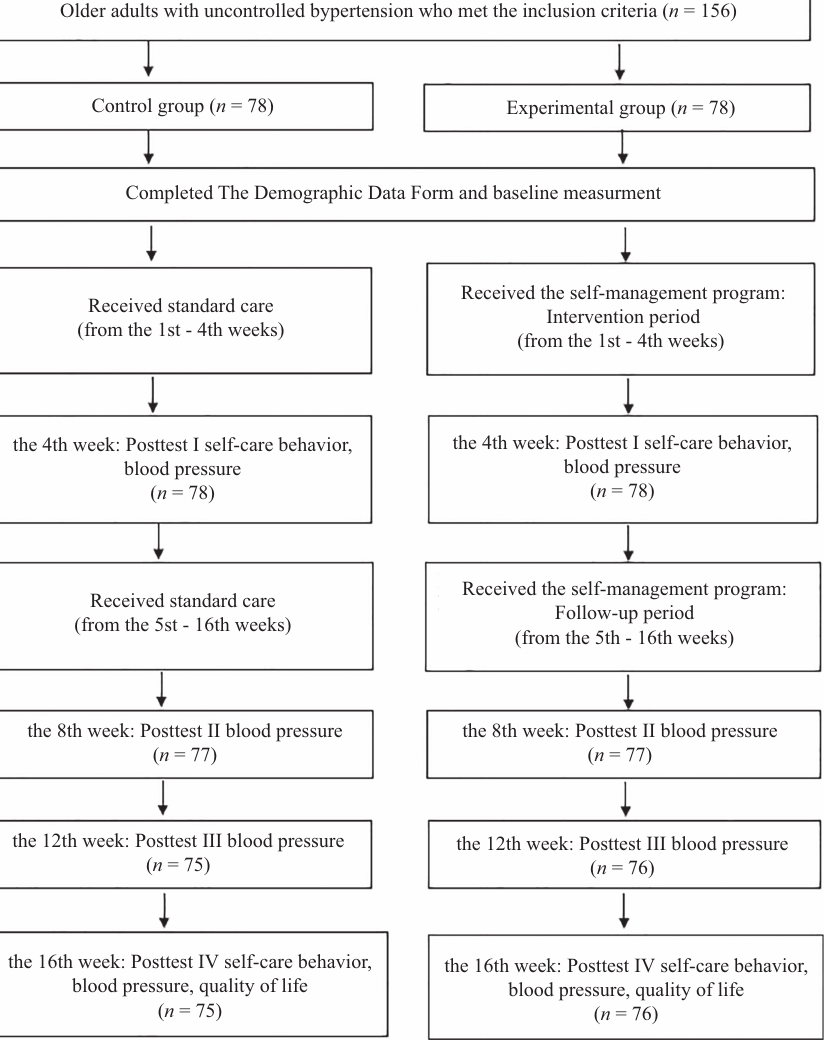
Figure 1. Flow chart of